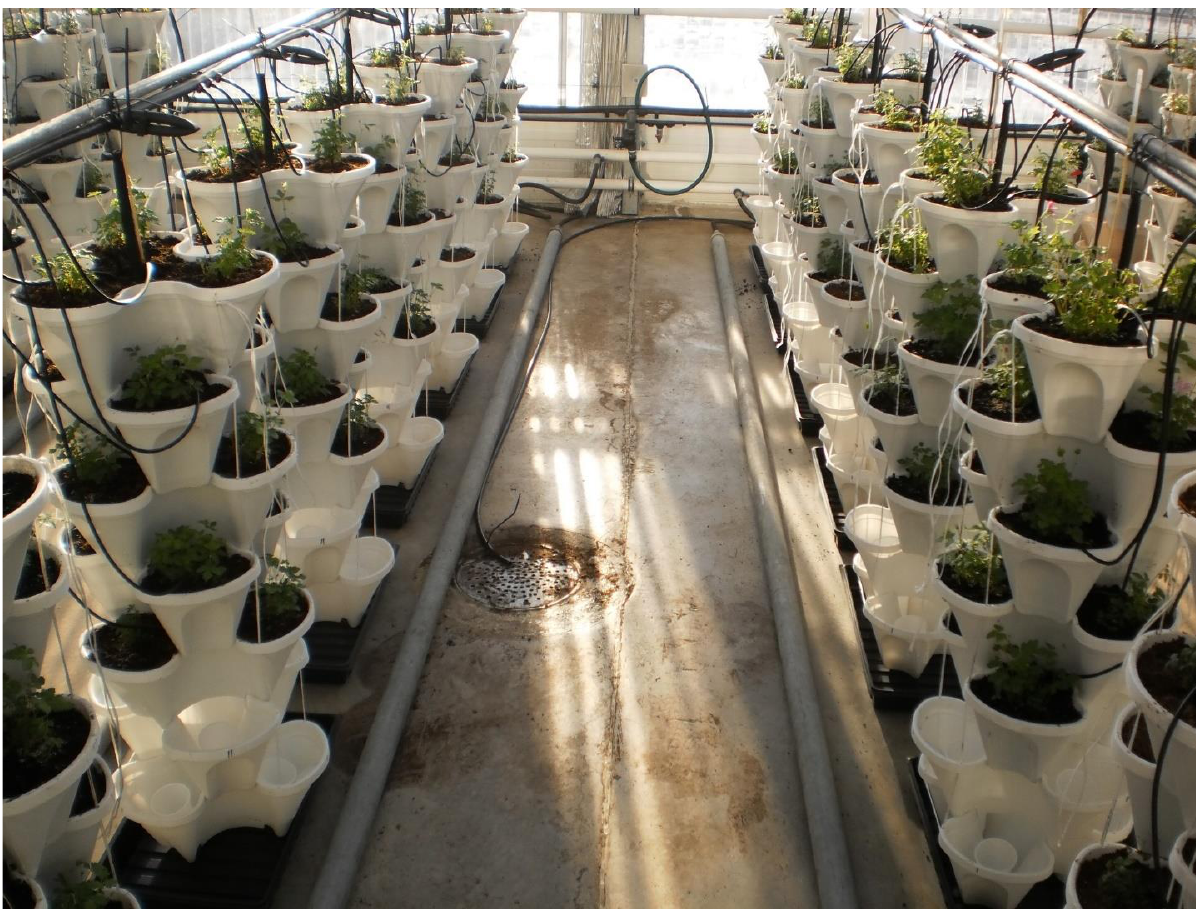
Figure 1. Plant towers consisting of three-lobed containers stacked seven atop each other in a greenhouse. The experimental arctic bramble plants are growing in the first, third and fifth containers from the top, which drain through each